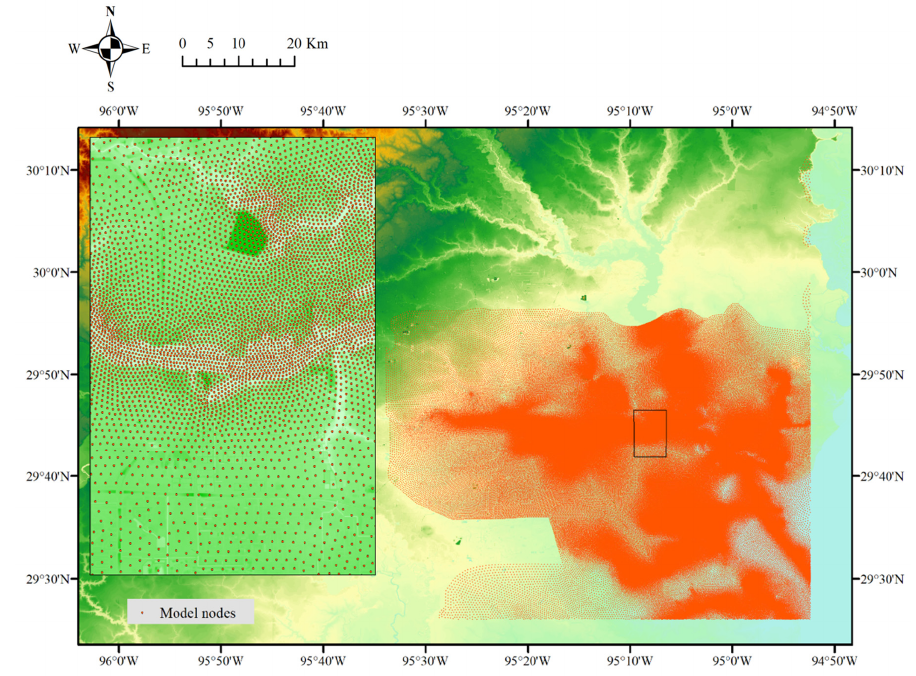
Figure 6. Storm surge model simulation nodes.